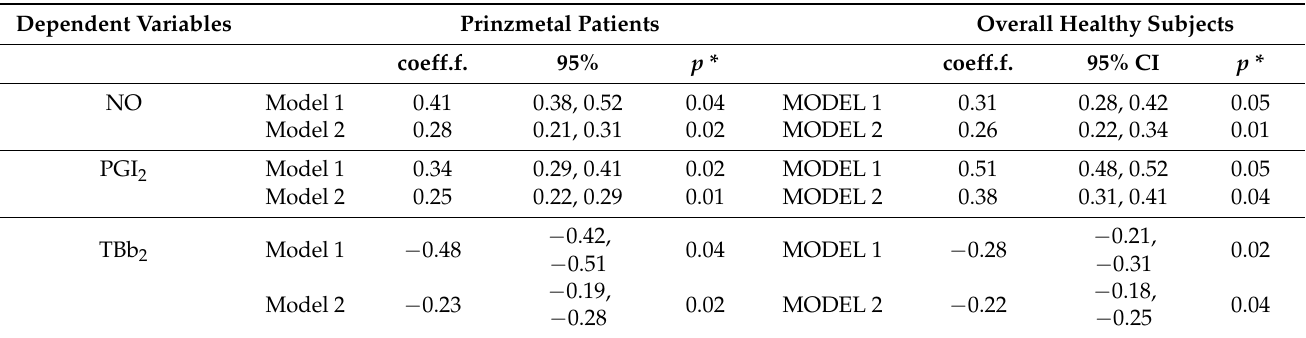
Table 3. Association between adherence to the Mediterranean diet with serum levels of Thromboxane B 2 , Prostacyclin, and Nitric oxide in the study groups.